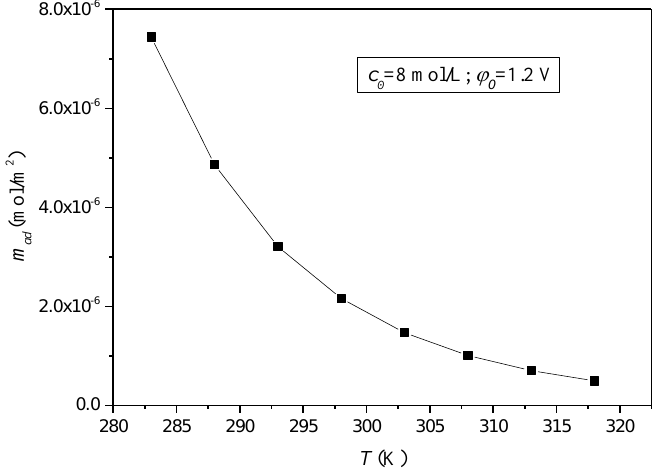
Figure 7. Adsorption capacity variation with different temperatures.